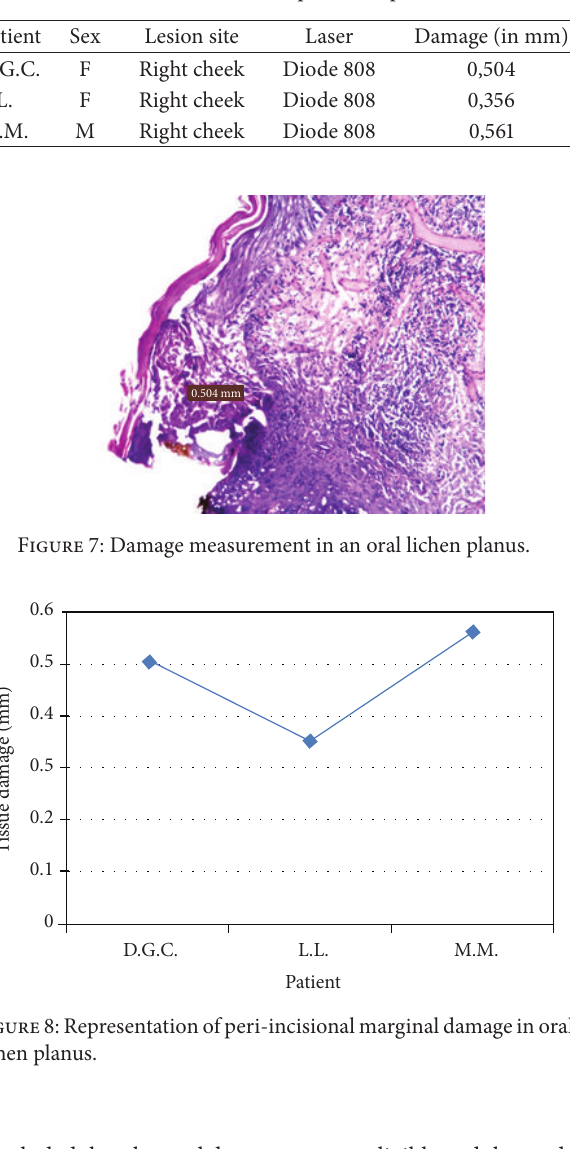
Table 4: Oral lichen planus biopsies.